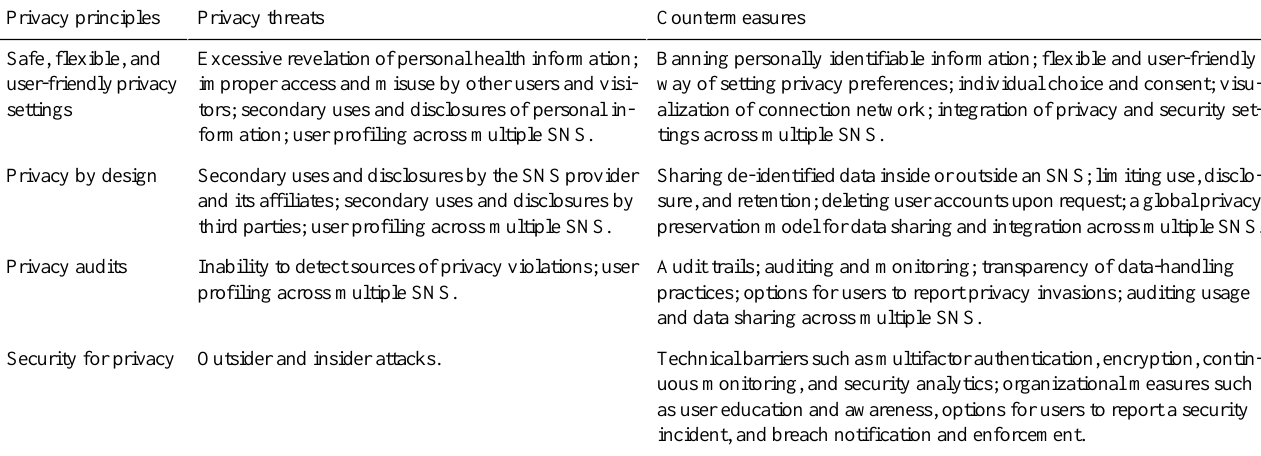
Table 2. Privacy threats and countermeasures.